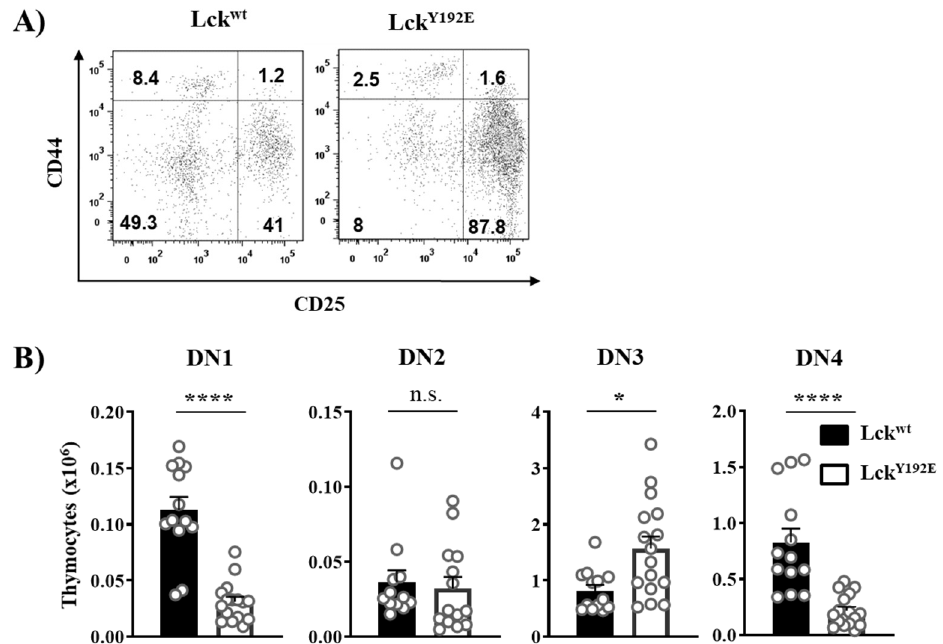
Figure 3. Developmental block at the β selection checkpoint in Lck Y192E mice. ( A ) To identify the four stages of DN thymocytes, isolated cells were stained with CD4, CD8, CD44, and CD25 antibodies. Cells were gated on DN thymocytes, and CD44 and CD25 expressions were analyzed. Numbers indicate percentages of the cells in each quadrant. One representative dot plot is shown. ( B ) Bar graphs represent summary statistics of the cell number in each DN subset, which are defined as: DN1 (CD25 − /CD44 + ), DN2 (CD25 + /CD44 + ), DN3 (CD44 − /CD25 + ), and DN4 (CD44 − /CD25 − ). Each dot shown represents one mouse, whereas columns show mean values of all analyzed mice + SEM ( n = 12–15). Statistical analyses were performed using an unpaired Student’s t test (* p ≤ 0.05, **** p ≤ 0.0001, n.s. = not statistically significant).